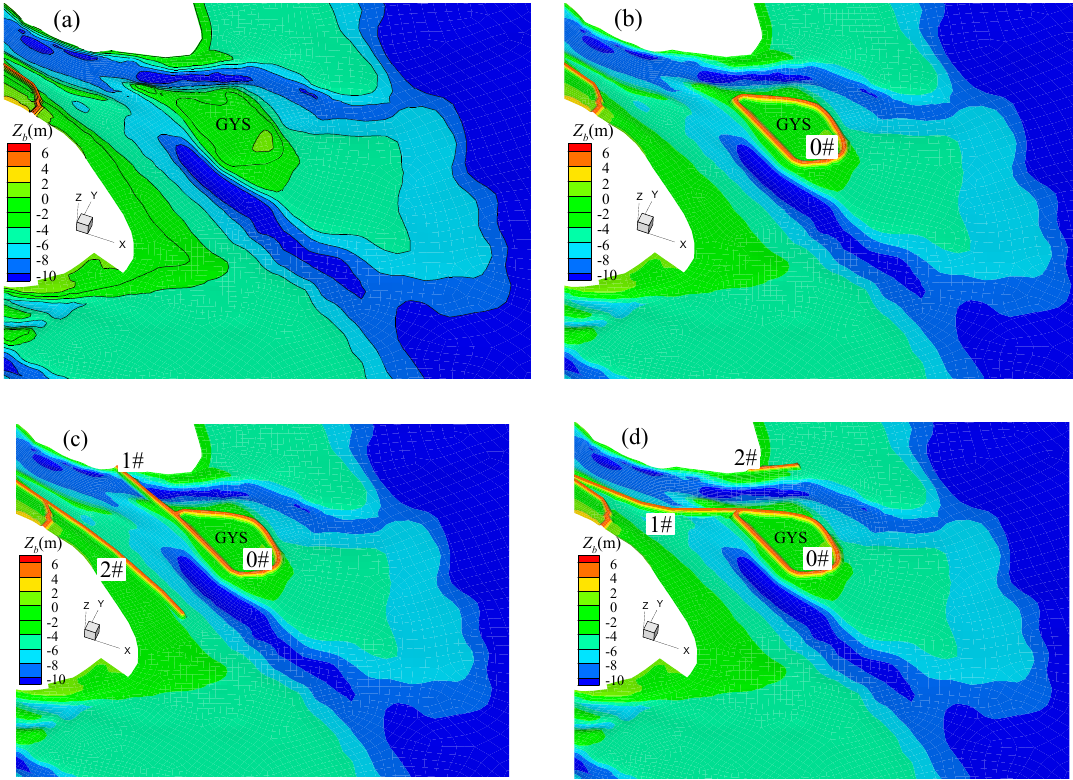
Figure 7. Arrangements of dikes: ( a ) Design “None”; ( b ) Design 1 (using two outlet channels); ( c ) Design 2 (using a southward outlet channel); ( d ) Design 3 (using a northward outlet channel).